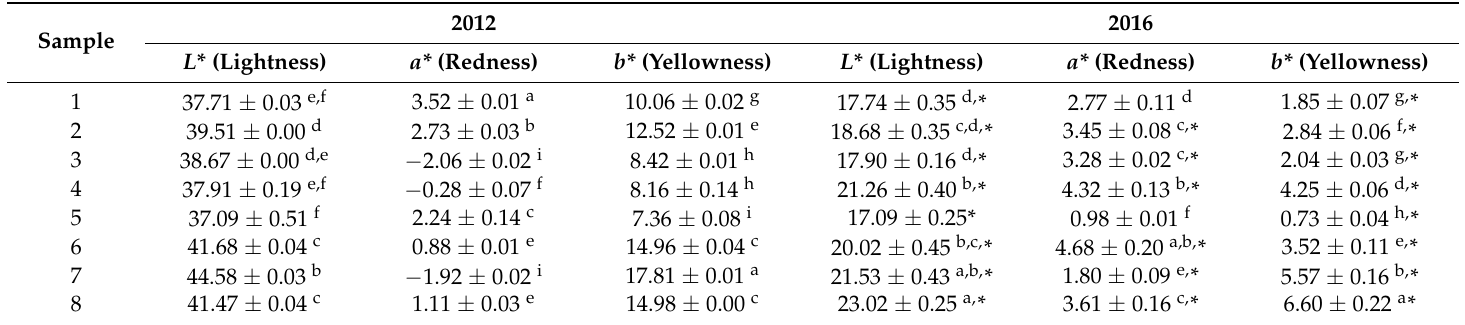
Table 2. Color variation during honey storage between 2012 and